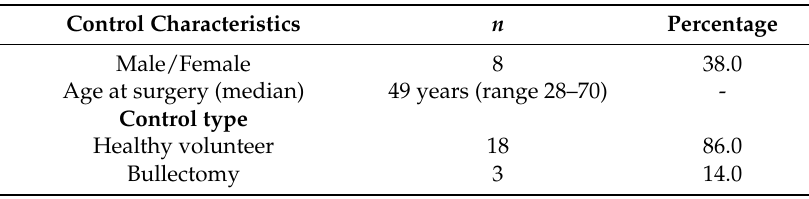
Table 3. Benign control